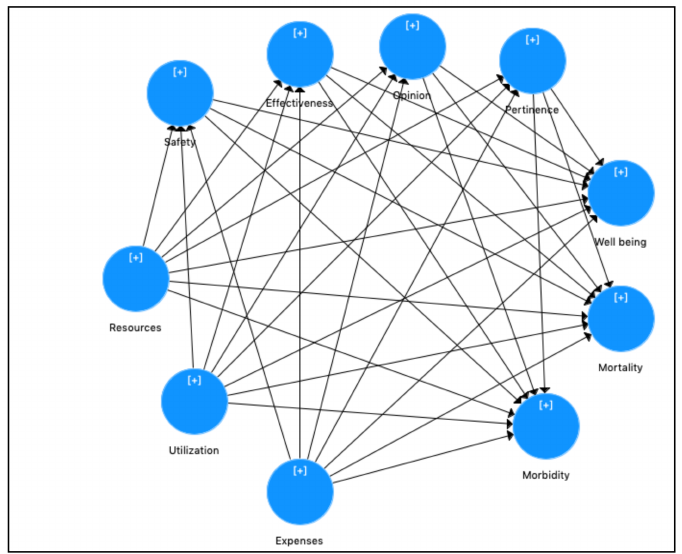
Figure 2. The first step: lower order components’ measurement model.